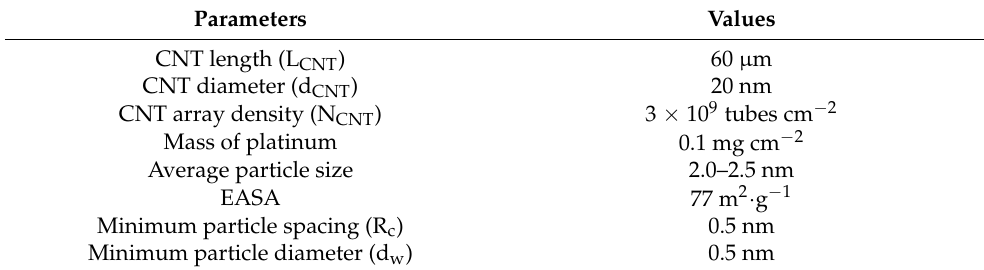
Table 1. Parameters of the CNT-based catalyst [25].